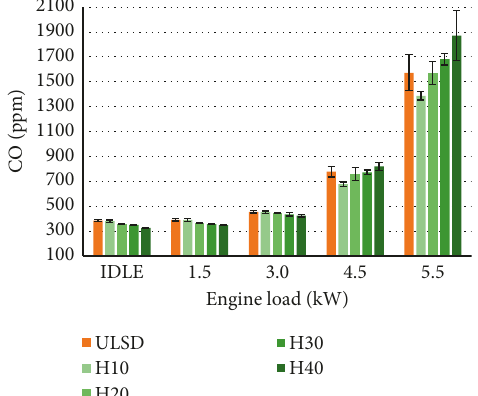
Figure 9: Carbon monoxide emissions for ULSD and HUCO blends for all